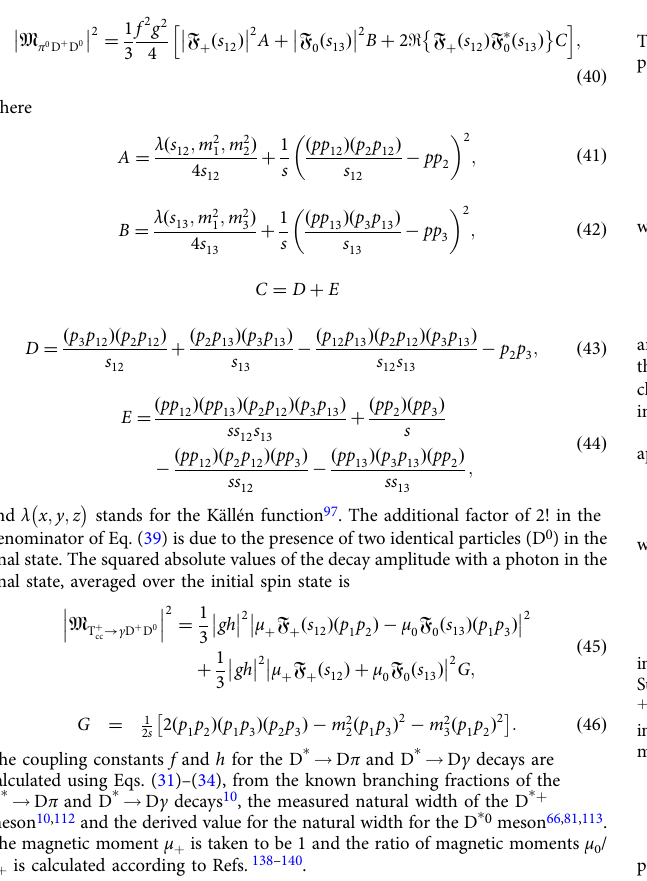
(cid:4) (cid:4) (cid:4) (cid:4) parameter, the F U signal (cid:4) (cid:4) (cid:4) (cid:4) parameter the